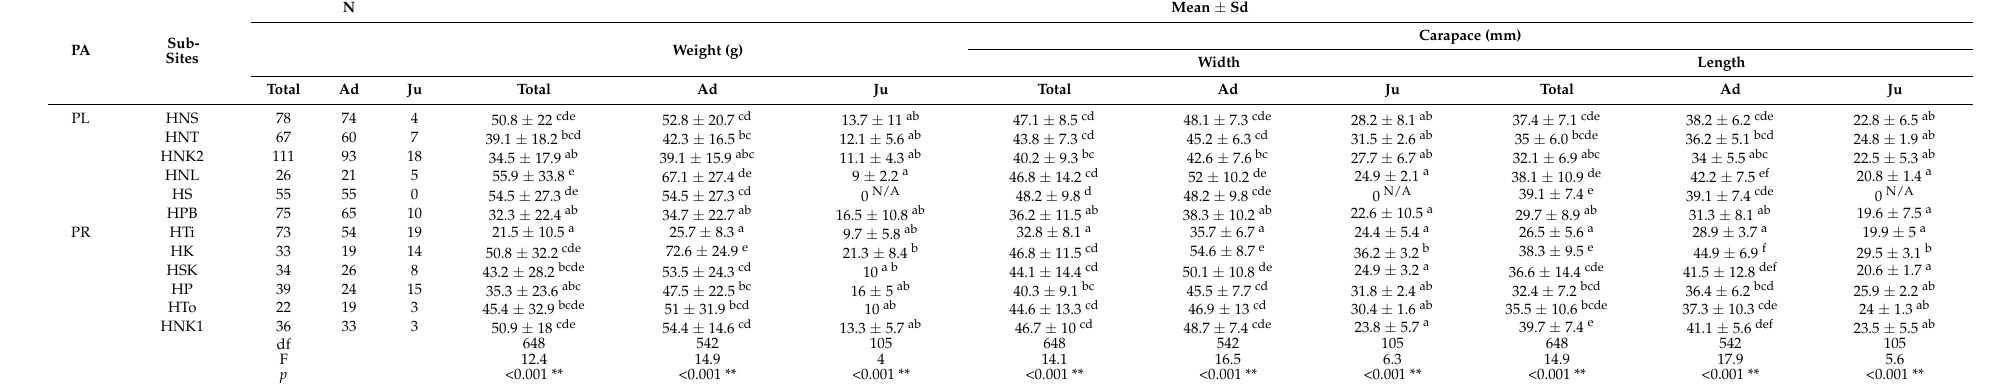
Table 4. Body size of male of I. bhumibol in Phu Luang Wildlife Sanctuary (PL) and Phu Ruea National Park (PR).